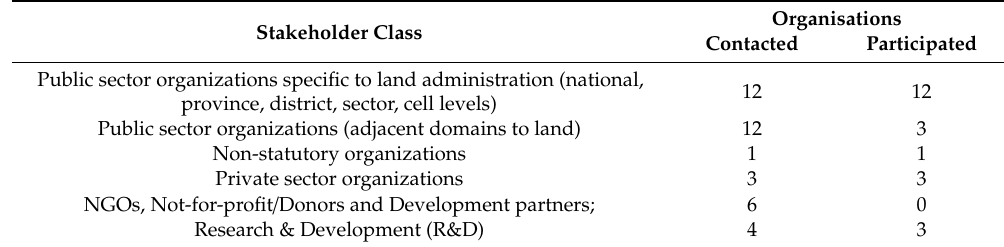
Table 1. Types of stakeholders participating in data collection workshops.